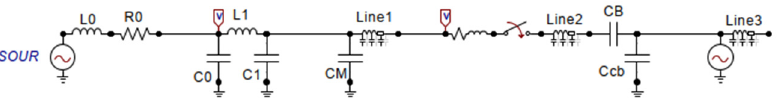
Figure 10. Simulation model of VFTO.